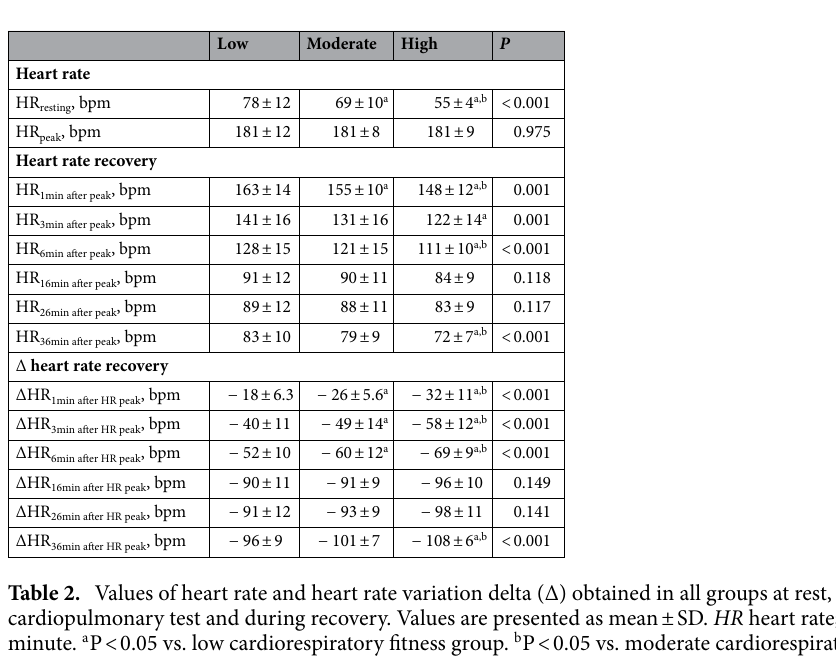
Table 2 shows the HR values during rest, peak exercise, and recovery (active and supine position). It also shows the HR variation delta (∆) during recovery. The HCF group had lower HR values at rest when compared to that in other groups. Peak HR was similar across all three groups. On the contrary, during recovery, the HCF group had lower values of HR and ∆HR, when compared to that in other groups, indicating a better recovery HR. Table 3 present the results of linear (spectral analysis) and non-linear analysis of HRV, both during base- line recording (supine rest) and recovery (supine recovery). Comparing rest and recovery period, the spectral analysis showed decrease in variance, LF in absolute units and HF in absolute and normalized units. It also showed increases in LF oscillations in normalized units and in the LF/HF ratio. Nonlinear analysis showed a reduction in entropy (ApEn) and in Poincare Plot parameters (SD1 and SD2), accompanied by increases in DFA parameters, α1 e α2. Table 4 present the results of BPV and BRS analysis, both obtained during baseline recording (supine rest) and recovery (supine recovery). Comparing rest and recovery period, the SBP analysis showed an increase of LF oscillations. In turn, the BRS parameters were reduced. In contrast, there was no cardiorespiratory fitness influence on HRV and BPV parameters and BRS (Tables 3 and 4). Figure 1 and Table 5 shows the blood lactate values during rest (resting), maximal cardiopulmonary test plateau (VO 2max ), and 10 min after the cardiopulmonary test maximum plateau (recovery period—10 min).